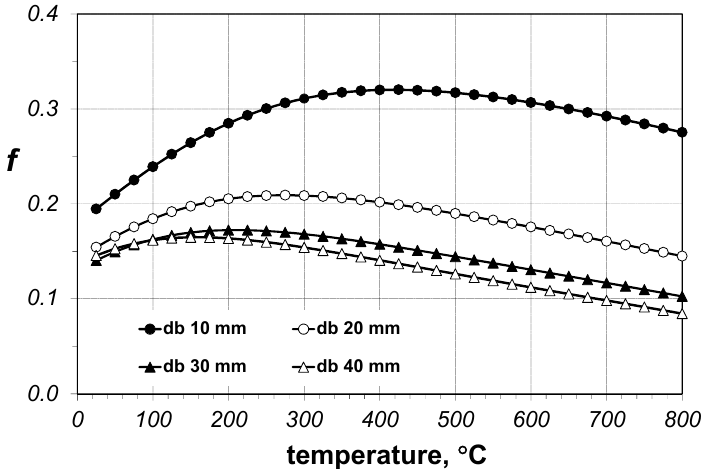
Figure 7. The values of the f coefficient depending on the bar diameter and temperature.